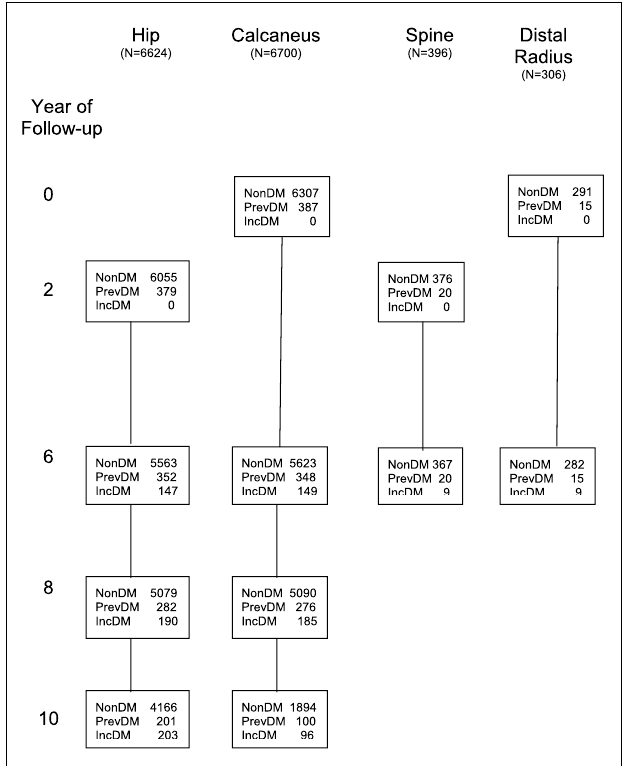
FIGURE 1 | Number of participants in each bone loss analysis by diabetes status at each visit . N , number of participants included in analysis of each skeletal site; non-DM, no DM at current or previous visits; PrevDM, DM at baseline; IncDM, new diagnosis of DM between baseline and current